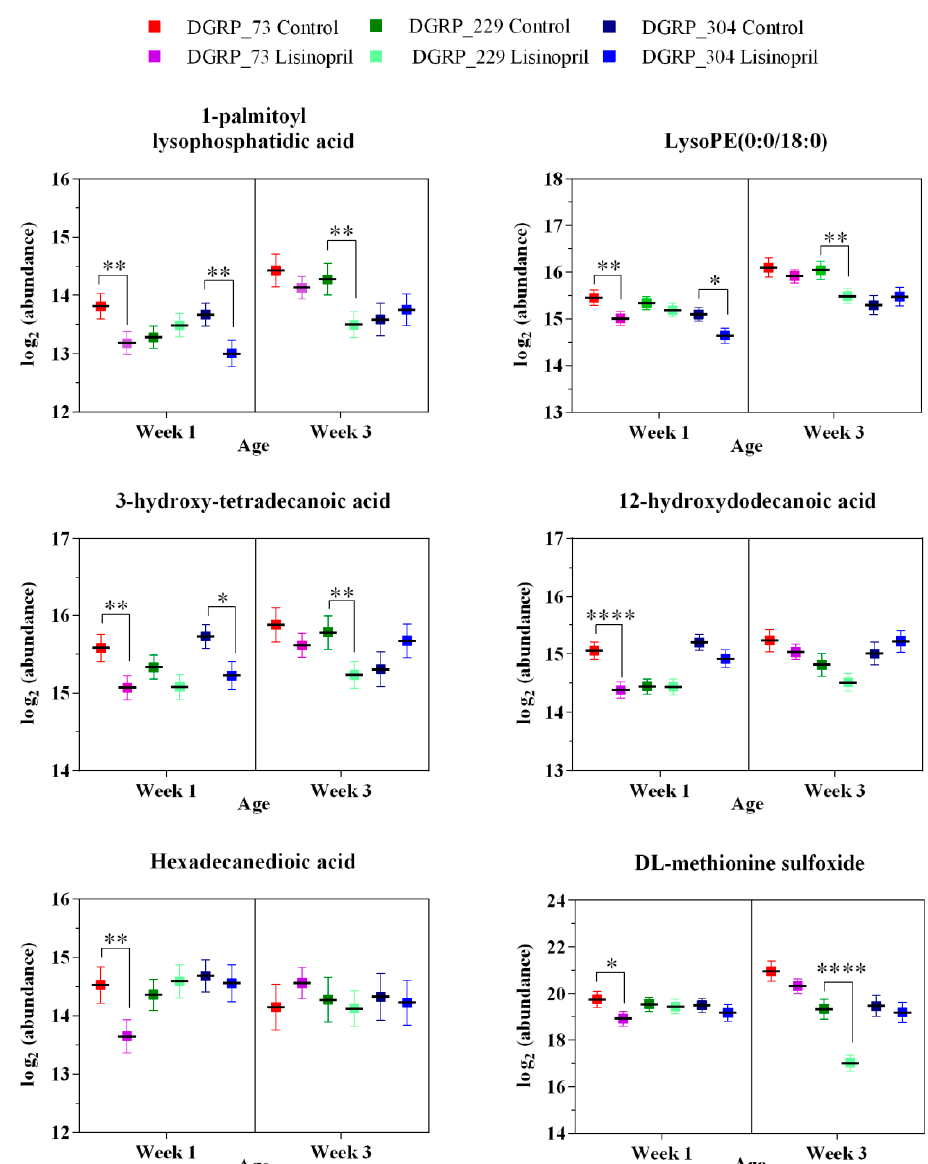
Figure 4. Thoracic metabolites with genotype- and age-specific changes in response to Lisinopril. Data reported on the plots denote the mean log 2 abundance of three replicate samples for each treatment, genotype, and age group. * p < 0.05, ** p < 0.01, and **** p < 0.0001 after Benjamini and Hochberg’s adjustment for multiple comparisons. Error bars represent the 95% confidence interval.